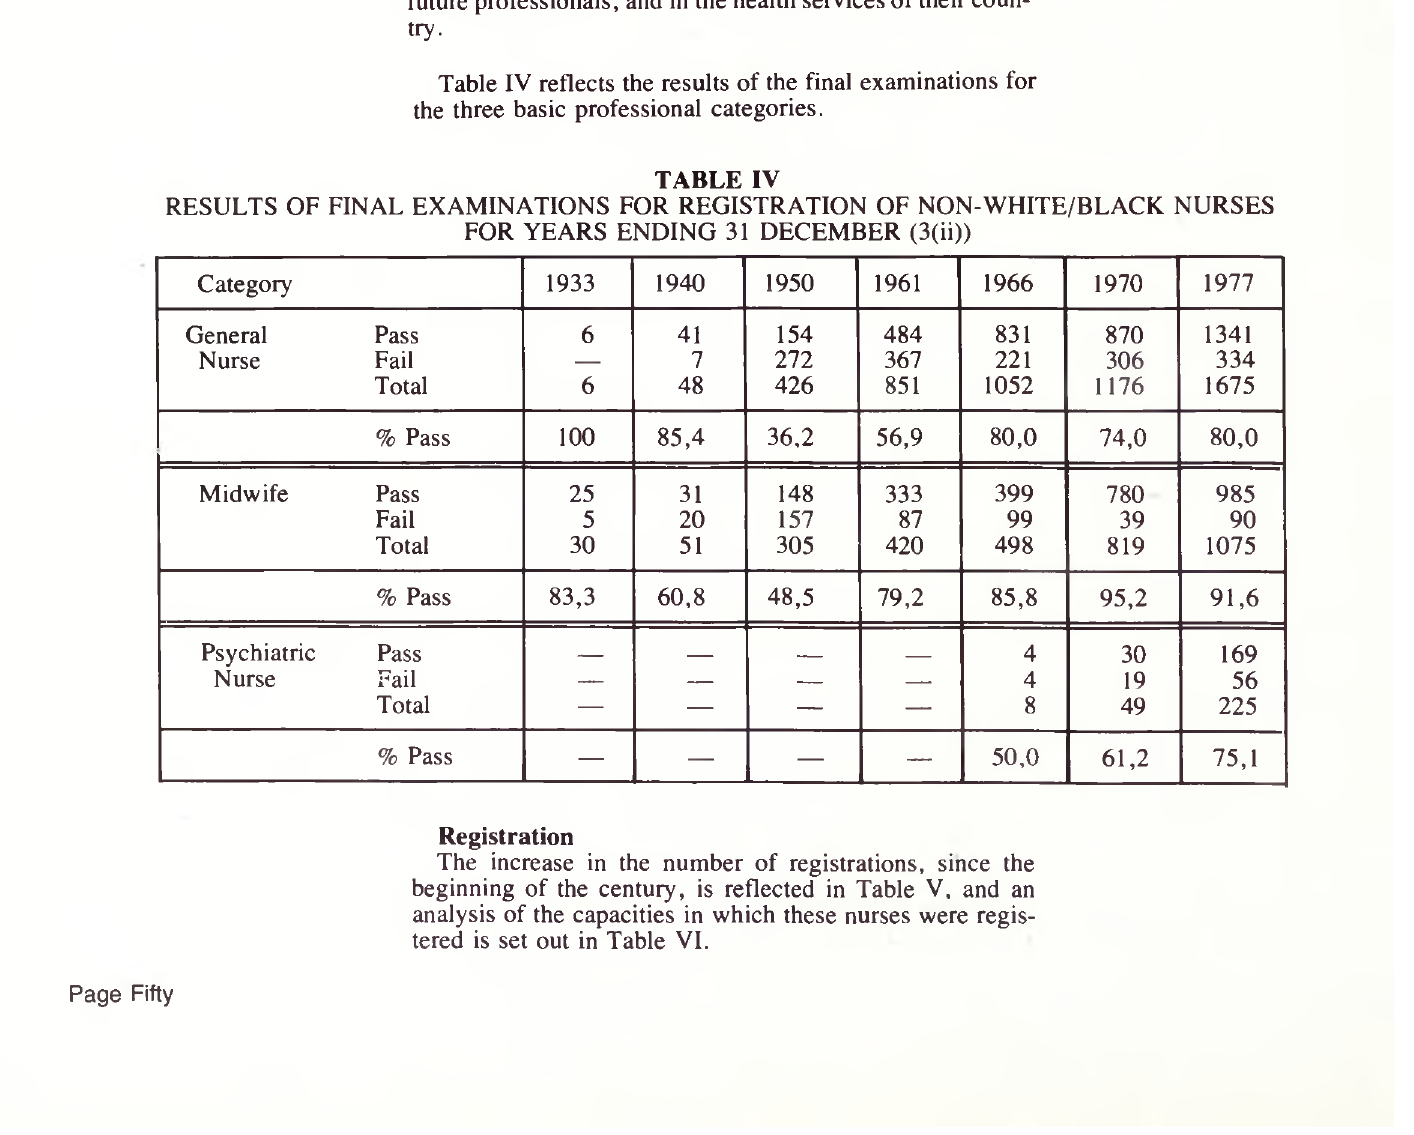
Table IV reflects the results of the final examinations for the three basic professional categories.